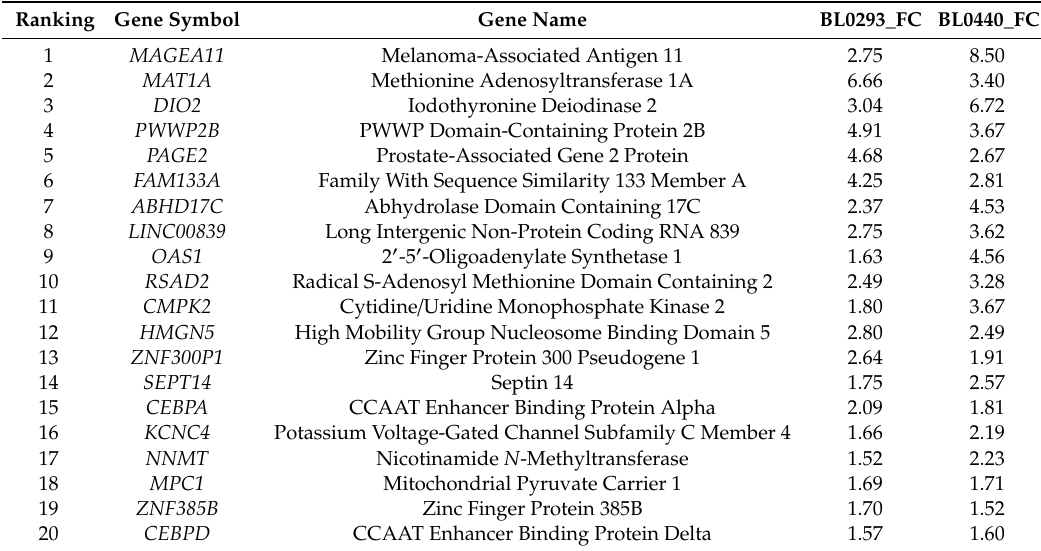
Table 1. Top 20 upregulated genes in drug relapsed PDX tumors.